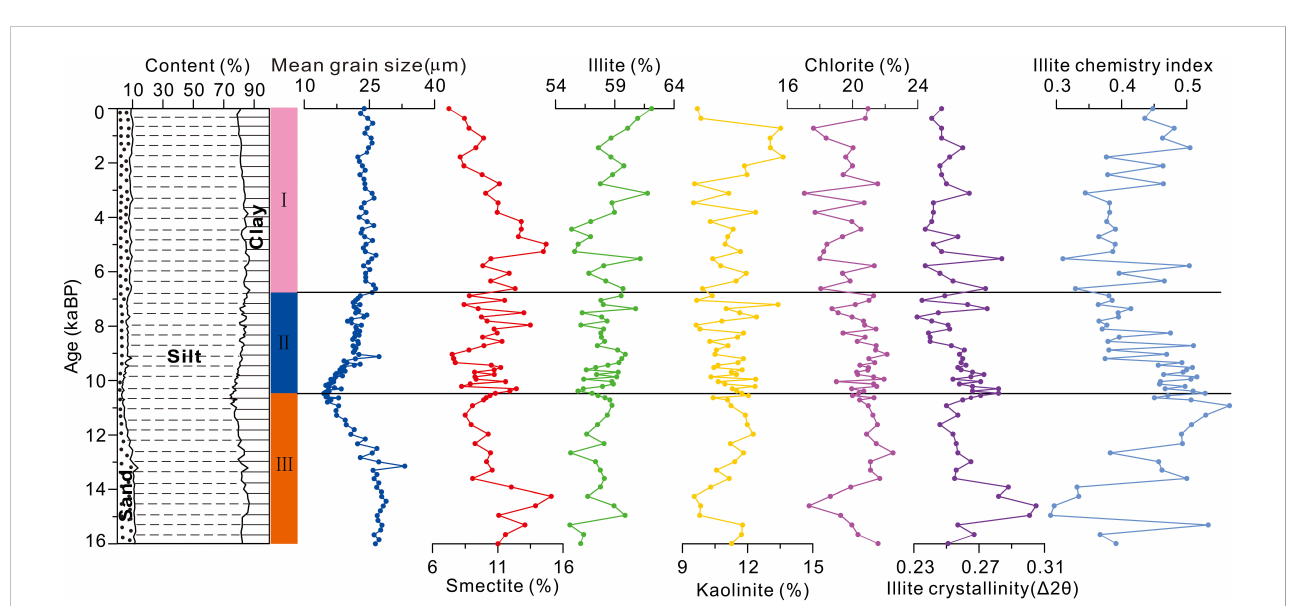
FIGURE 3 Lithology, mean grain size, clay mineral assemblages, crystallinity index, and chemical index of core